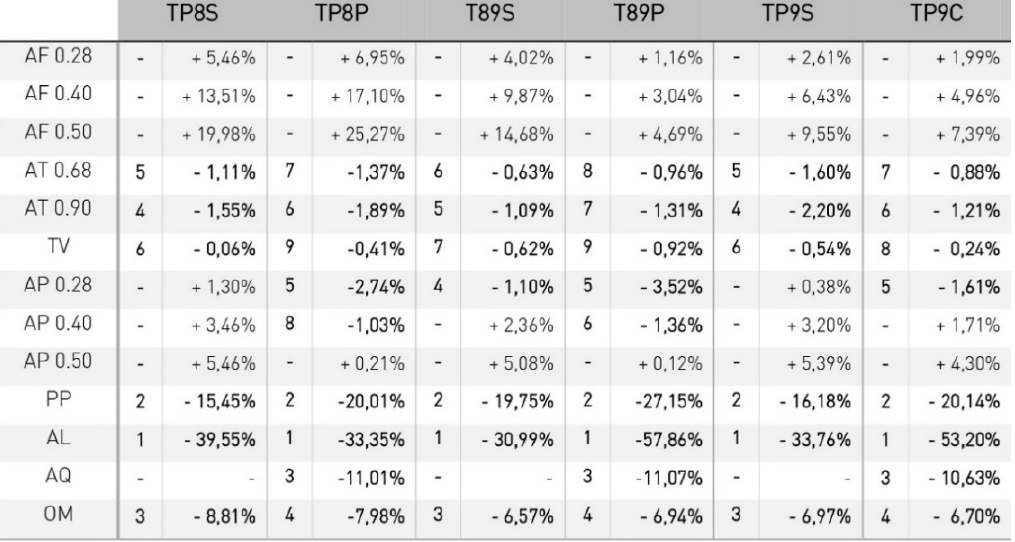
Figure 12. Preferable adopted solutions in test spaces and comfort performances (PMV).